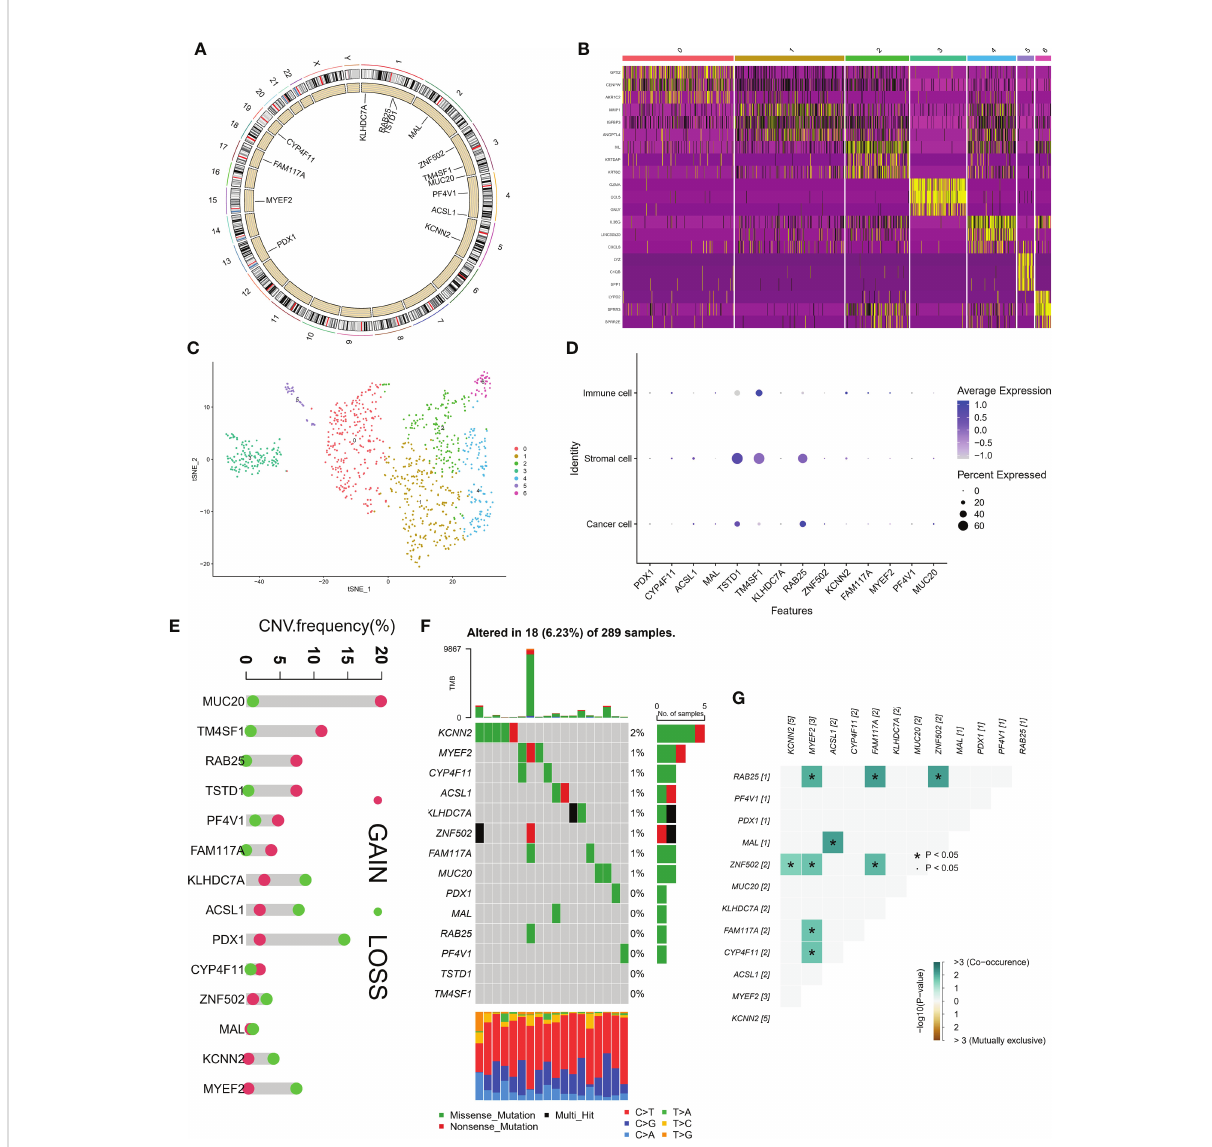
FIGURE 2 Genomic landscape of methylation driven genes. (A) Localization of methylation driven genes in chromosomes. (B) Expression levels of methylation driven genes in seven cell subsets. (C) Spatial distribution in seven cell subsets. (D) Average expression of methylation driven genes in three cell subsets. (E) CNV frequency of methylation driven genes. (F) tumor Mutation burden of methylation driven genes in samples. (G) Interaction between methylation driven